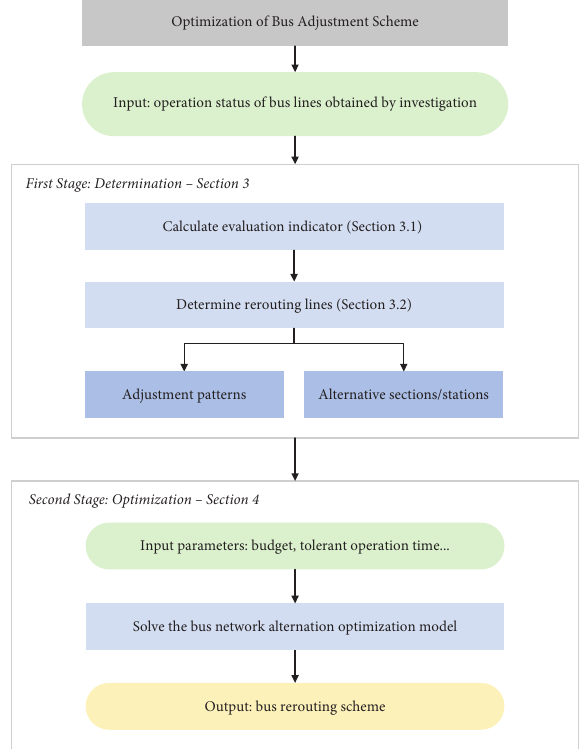
Figure 2: Flowchart of the two-stage optimization method. Table 1: Illustration of the